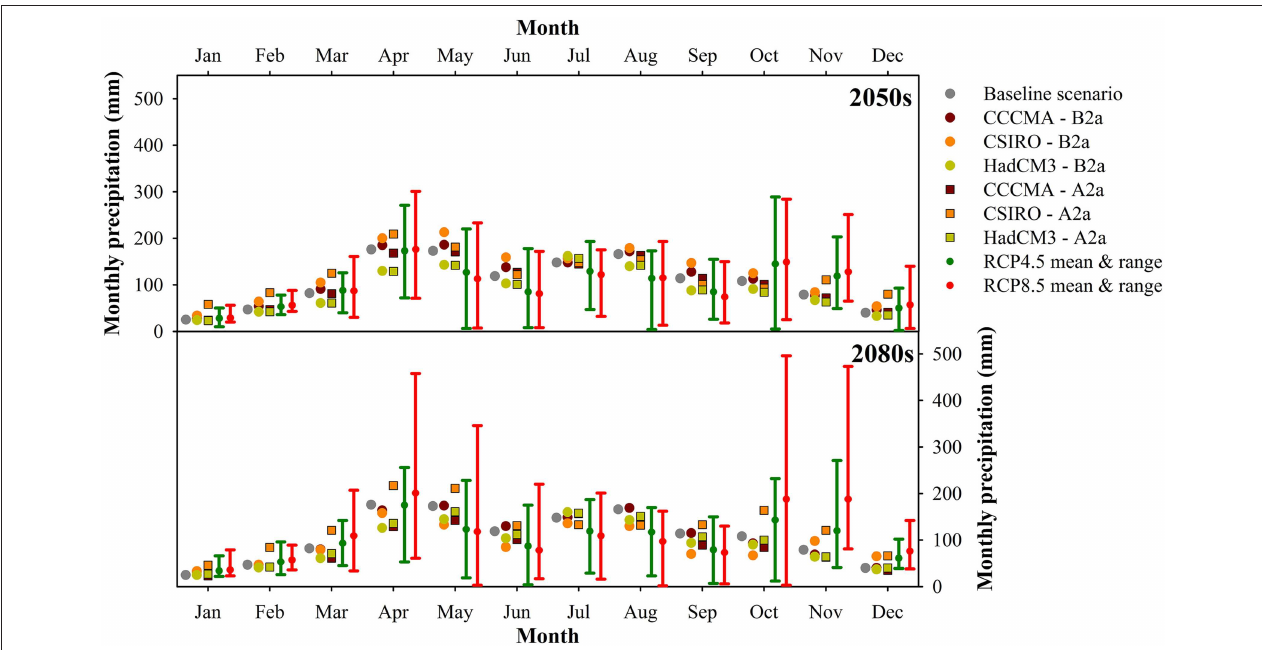
FIGURE 3 | Total precipitation for each month at the baseline location, according to different climate datasets: gray dots show current conditions according to the WorldClim database, brown, orange, and yellow circles (B2a emissions) and squares (A2a emissions) indicate projections with the CCCMA CGCM2, CSIRO MK2, and HadCM3 climate models, according to AR4 scenarios used in this study. The green and red dots with error bars show the means and ranges of projections from the AFRICLIM climate model ensemble (Platts et al., 2015), which uses projections from 10 General Circulation Models for the RCP4.5 and RCP8.5 radiative forcing scenarios of the 5th Assessment Report of the IPCC (2013), downscaled with five Regional Climate Models and additional statistical downscaling procedures (details on the methodology and models used are in the main